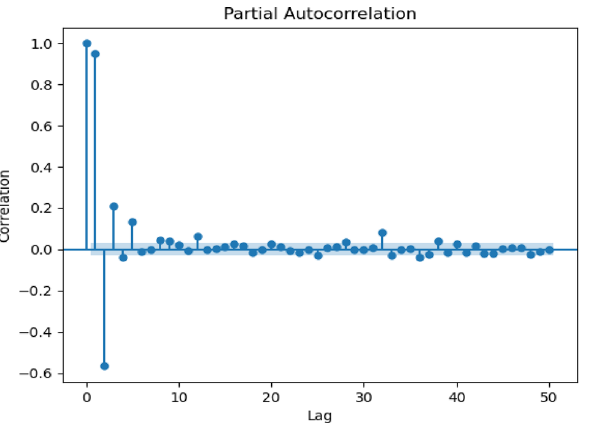
Figure 5. Partial autocorrelation for daily